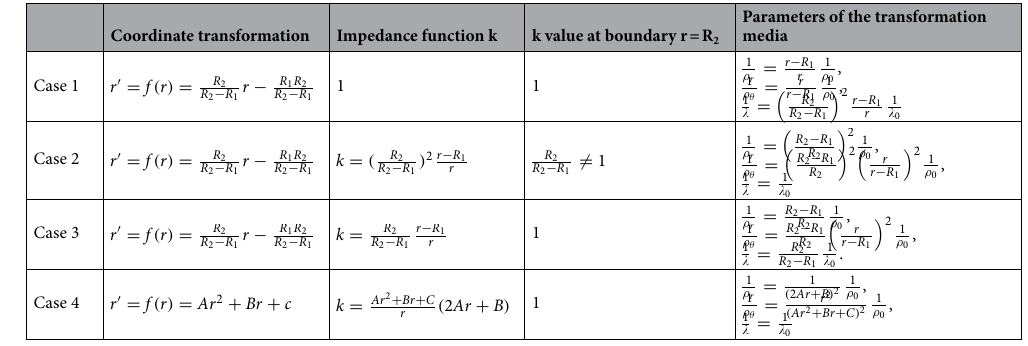
Table 1. The four different cloak